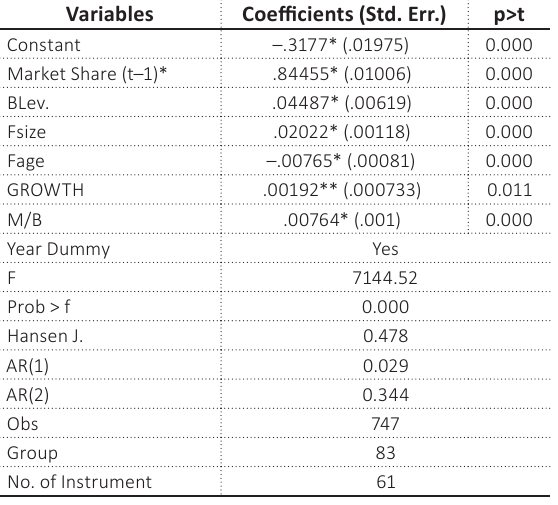
Table 6. Impact of capital structure on performance: Two-step GMM estimation